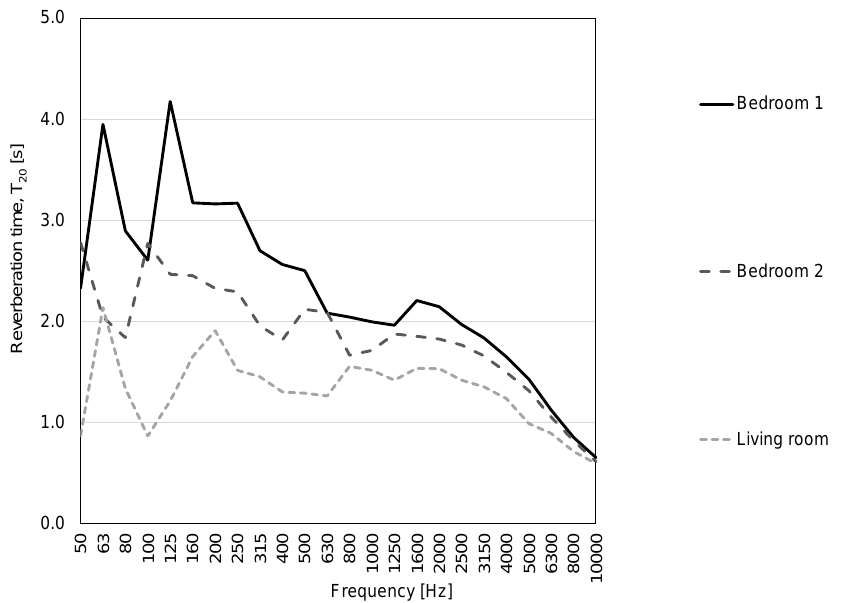
Figure 6. Reverberation time of bedroom 1, bedroom 2 and living room.